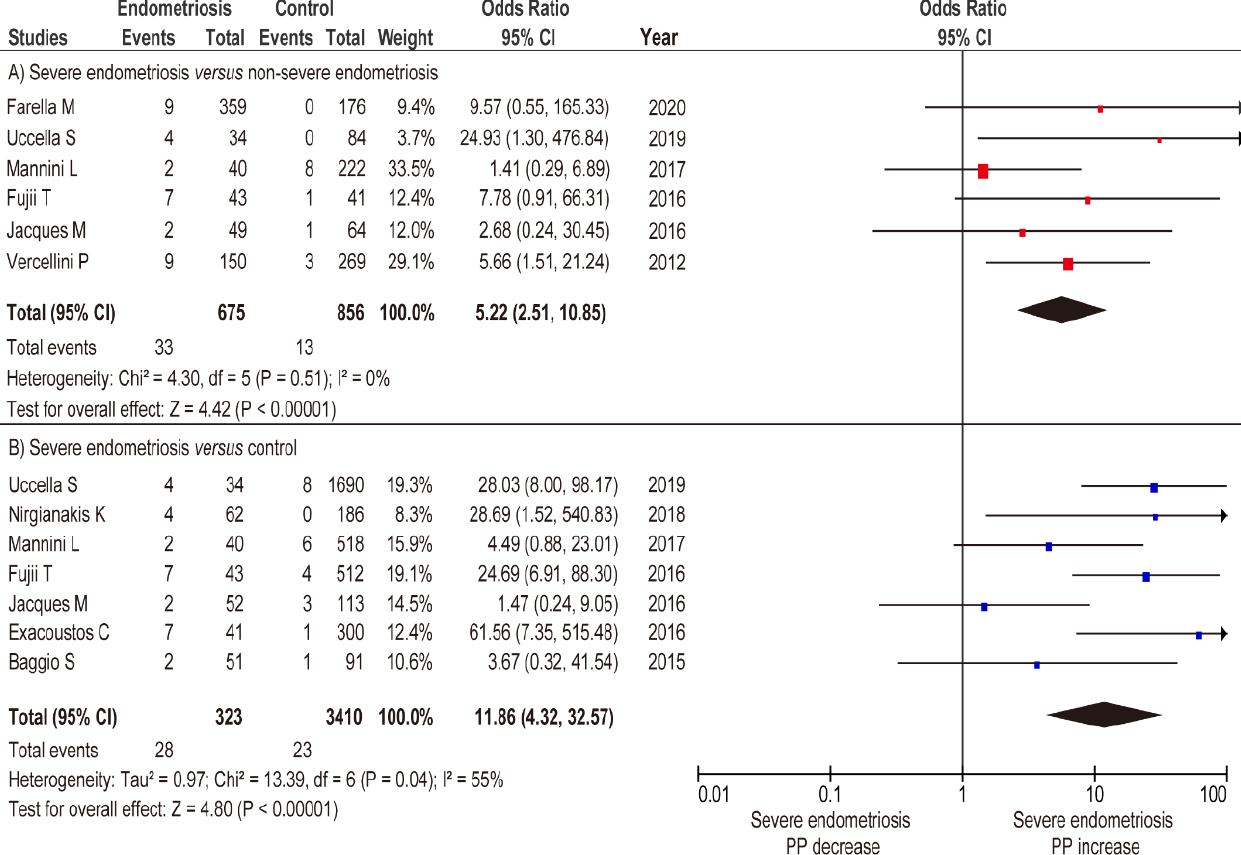
Figure 4. Meta-analysis of the influence of severe endometriosis on the incidence of PP. Pooled odds ratio of unadjusted analyses for PP. The position of the box is a point estimate of the OR. The size of the box represents the weight of study. A horizontal line representing the 95%CI of the study result, with each end of the line representing the boundaries of the CI. Clip CIs to arrows when they exceed specified limits. The diamond represents the combined results of the studies. ( A ) Severe endometriosis versus non-severe endometriosis, and ( B ) severe endometriosis versus control. The forest plots were arranged within the stratum by year of publication and the relative weight (%) of the study. No heterogeneity was observed in the analysis of A ( I 2 = 0%), while moderate heterogeneity was observed in the analysis of B ( I 2 = 55%). Therefore, a fixed-effects analysis was applied to panel A, whereas a random-effect analysis was used for panel B. Some values may be slightly different from the original values, as calculations were performed using Revman ver. 5.4.1. Abbreviations: OR, odds ratio; SE, standard error; CI, confidence interval; PP, placenta previa.